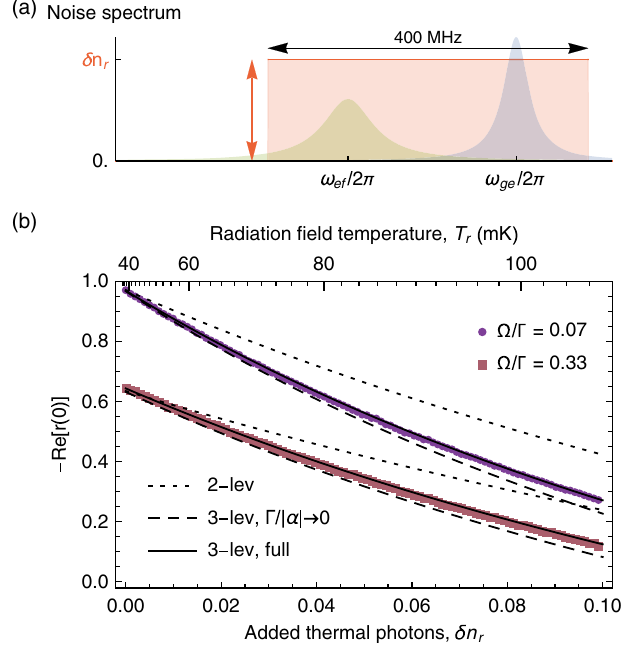
FIG. 3. Radiation-field thermometry with artificial white noise. (a) Sketch of the power spectral density of the applied noise (solid red line), with the relevant transmon transitions indicated on the frequency axis. The noise is white over a frequency band of 400 MHz and has a calibrated spectral density δ n . Blue and r green shades indicate the spectral densities of the transmon transitions, with a relative scaling reflecting their participation in the thermometry signal. (b) Measured real part of the reflection coefficient at resonance, − Re ½ r ð 0 Þ(cid:3) , at two selected drive strengths, Ω = Γ ¼ 0 . 07 and 0.33, versus calibrated noise power expressed in added thermal photons, δ n . The data (symbols) are r directly compared to increasingly refined models, without free parameters: two-level theory (short dashes), three-level theory assuming a small linewidth-to-anharmonicity ratio, Γ = j α j → 0 (long dashes), and three-level theory taking the measured ratio Γ = j α j ¼ 0 . 18 into account (solid